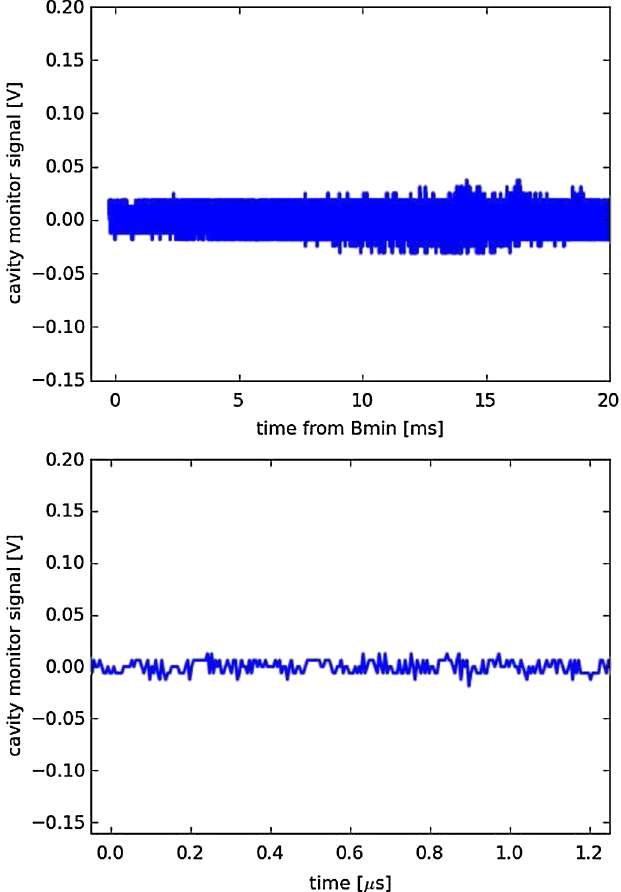
FIG. 9. The gap voltage monitor signal of cavity #10 (channel 3) with feedforward on. The envelope of full waveform from the injection to the extraction (upper) and a magnified view near the extraction (lower). The wake voltage is canceled and only a noise signal is remaining.